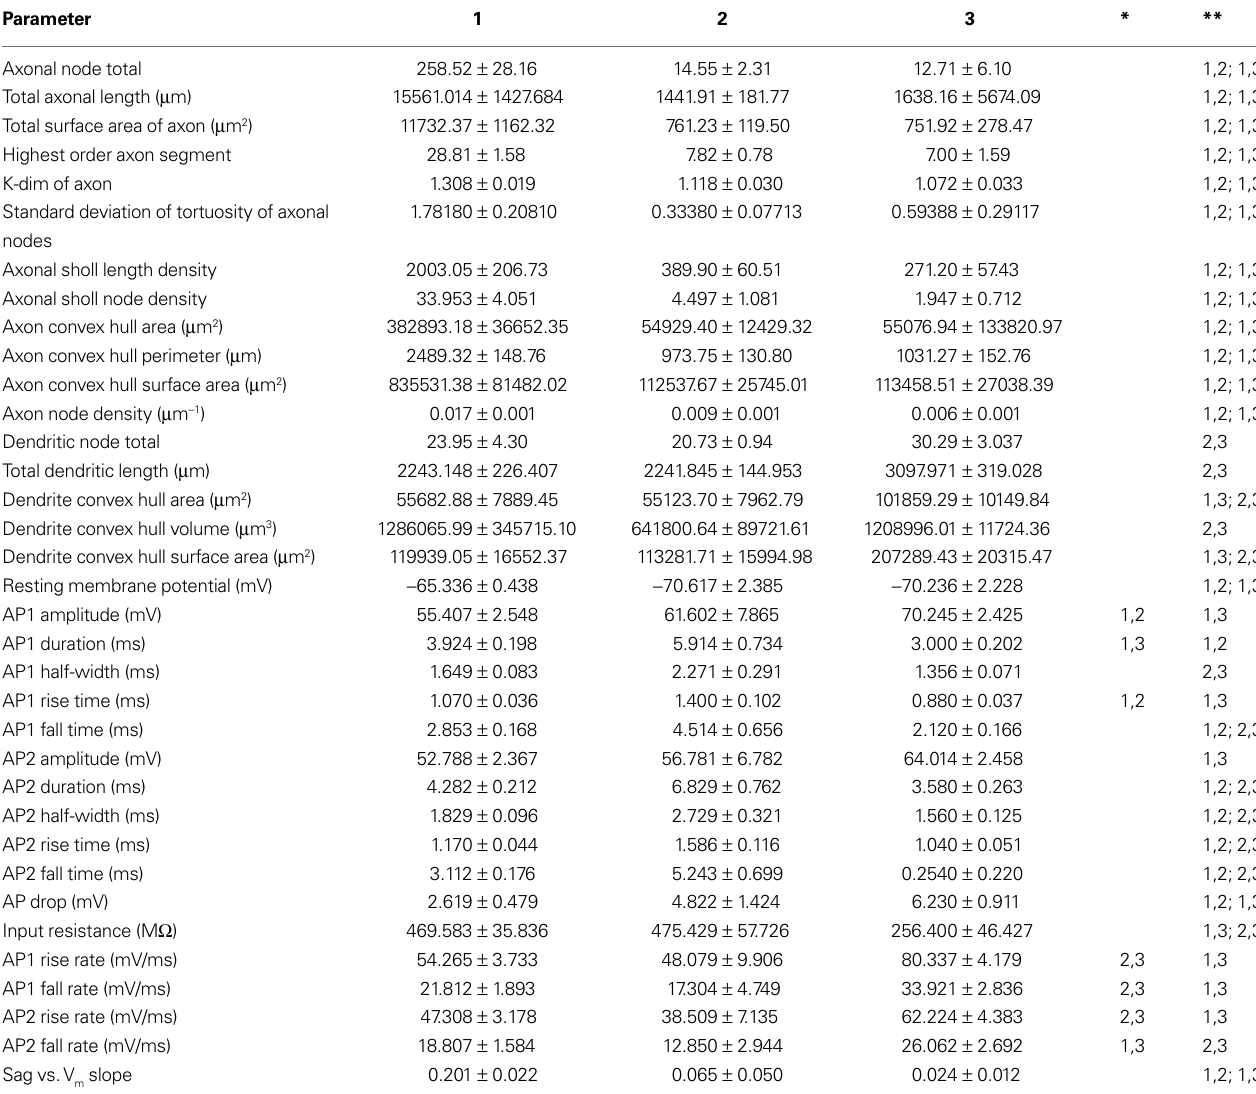
Table 3 | Average values ± standard error for the morphological and electrophysiological variables with signifi cant differences between groups.